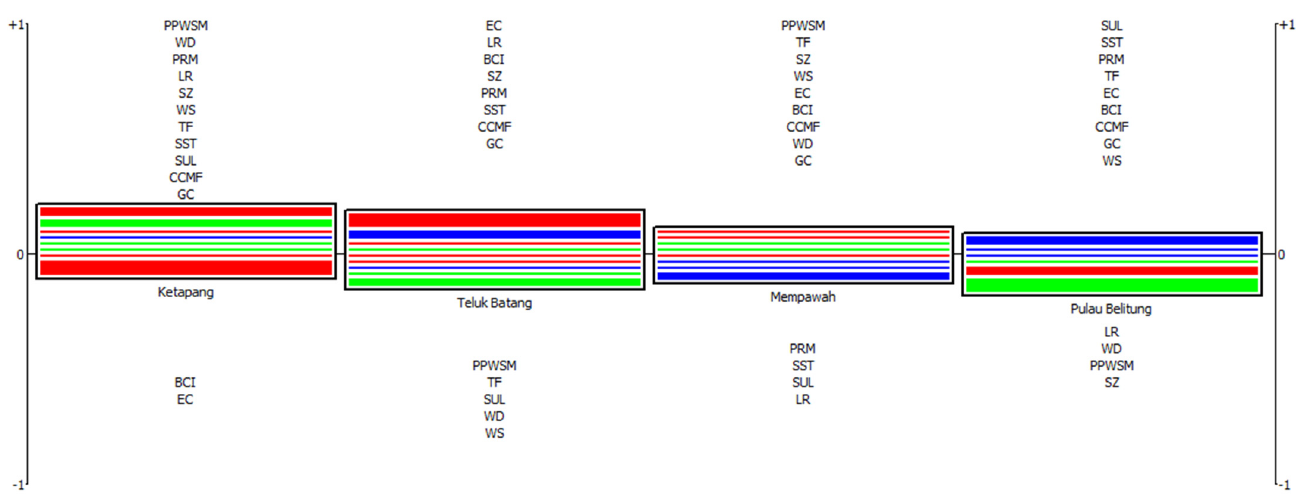
Figure 5. PROMETHEE rainbow for four pilot plant site selections.